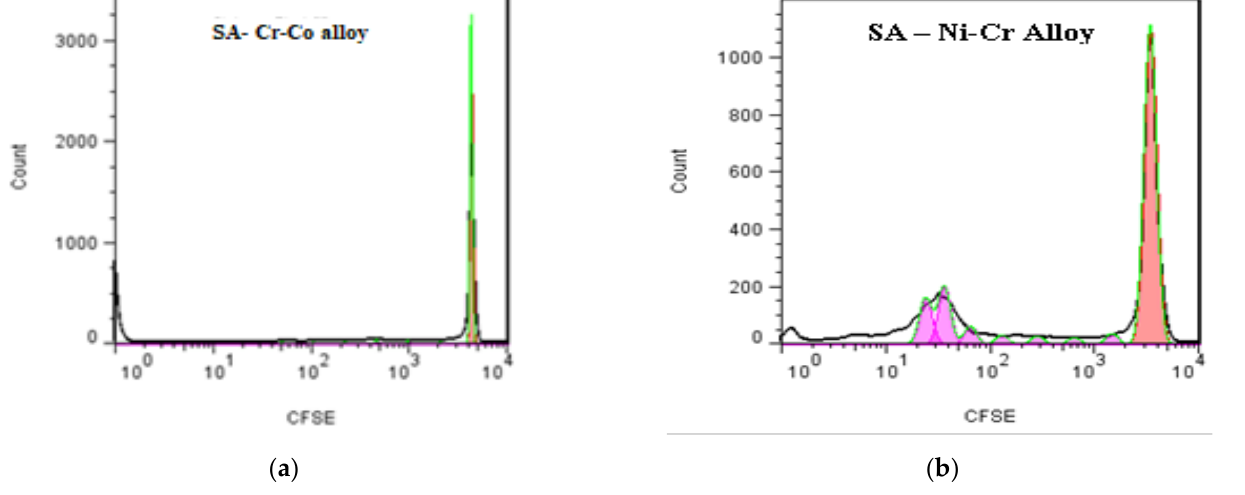
Figure 12. The process of cell proliferation of renal cell cultures, recorded by flow cytometer with blue laser (488 nm), under the conditions of their treatment with ionic eluate, from the incubation Cr-Co alloy ( a ) and Ni-Cr ( b ) with artificial saliva.